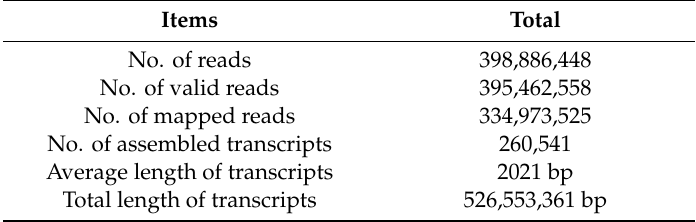
Table 1. Summary of rose peduncles parts transcriptome sequencing